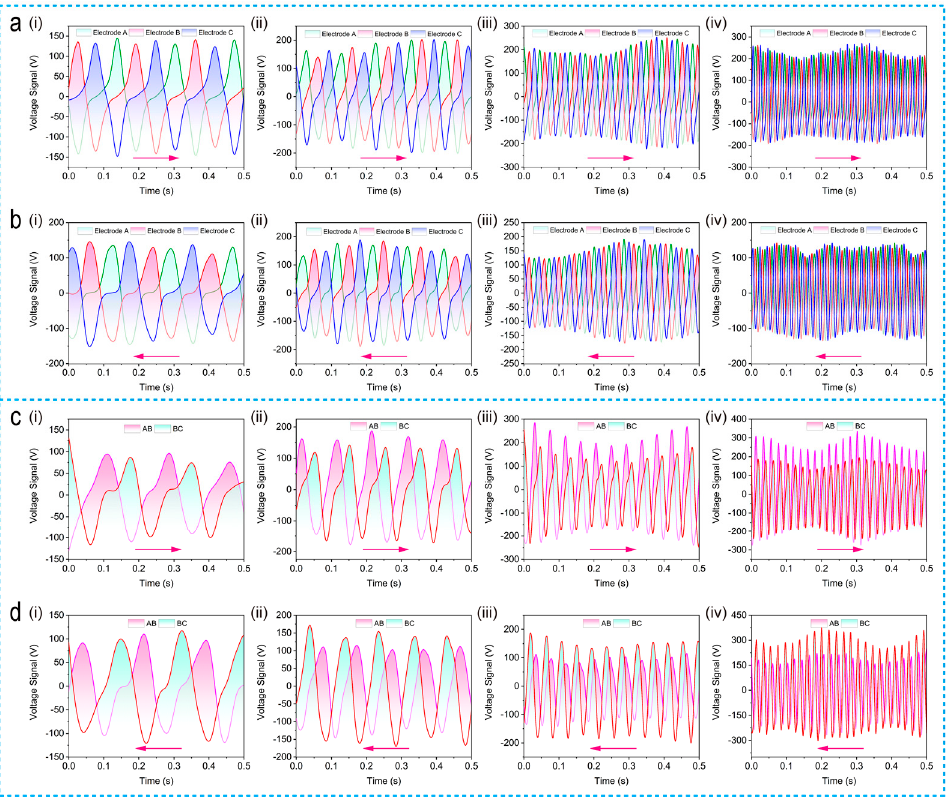
Figure 6. Measurement results of SPVSs’ electrical outputs working in different connection mode. ( a ), ( b ) Output voltage of disc-shaped SPVS at clockwise and anti-clockwise rotation speed of 24, 48, 96, and 192 rpm, respectively, under the first connection mode. ( c ), ( d ) Output voltage of disc-shaped SPVS at clockwise and anti-clockwise rotation speed of 24, 48, 96, and 192 rpm, respectively, under the second connection mode.